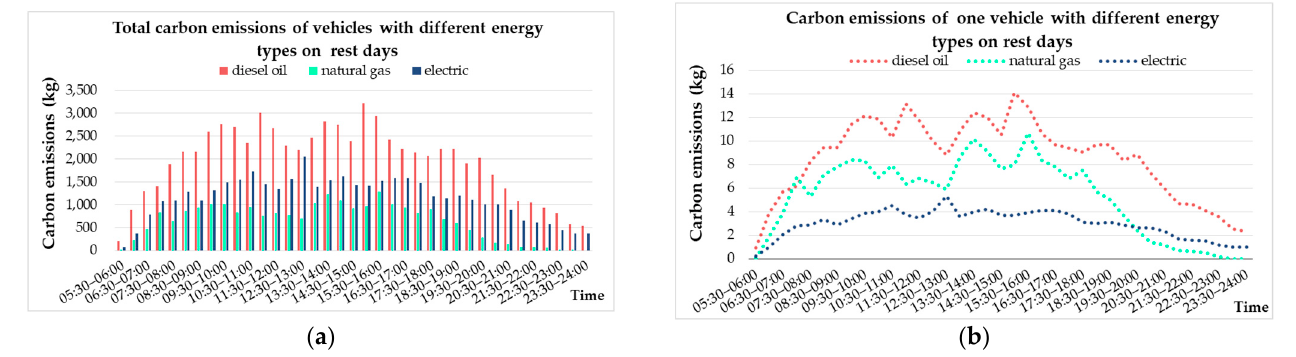
Figure 7. Time distribution of different types of buses’ carbon emissions in Sanya on rest days. ( a ) Total carbon emissions of vehicles with different energy types on rest days. ( b ) Carbon emissions of one vehicle with different energy types on rest days.